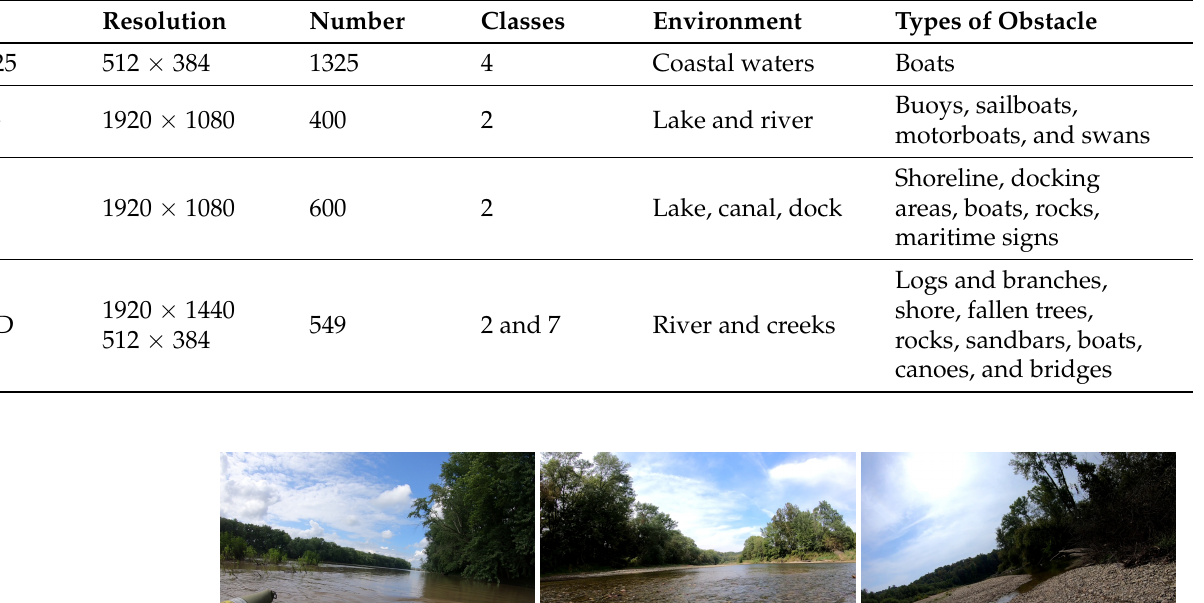
Table 1. Dataset comparison between MaSTr1325 [6], Waterline [9], Tampere-WaterSeg [35,40], and ROSEBUD.